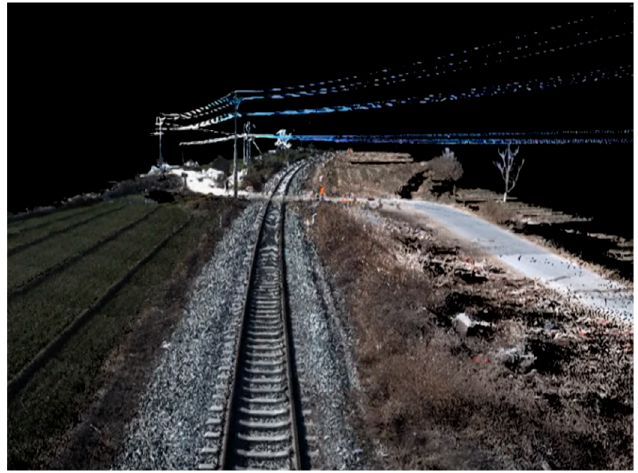
Figure 7. A close-up view of the railroad infrastructure.